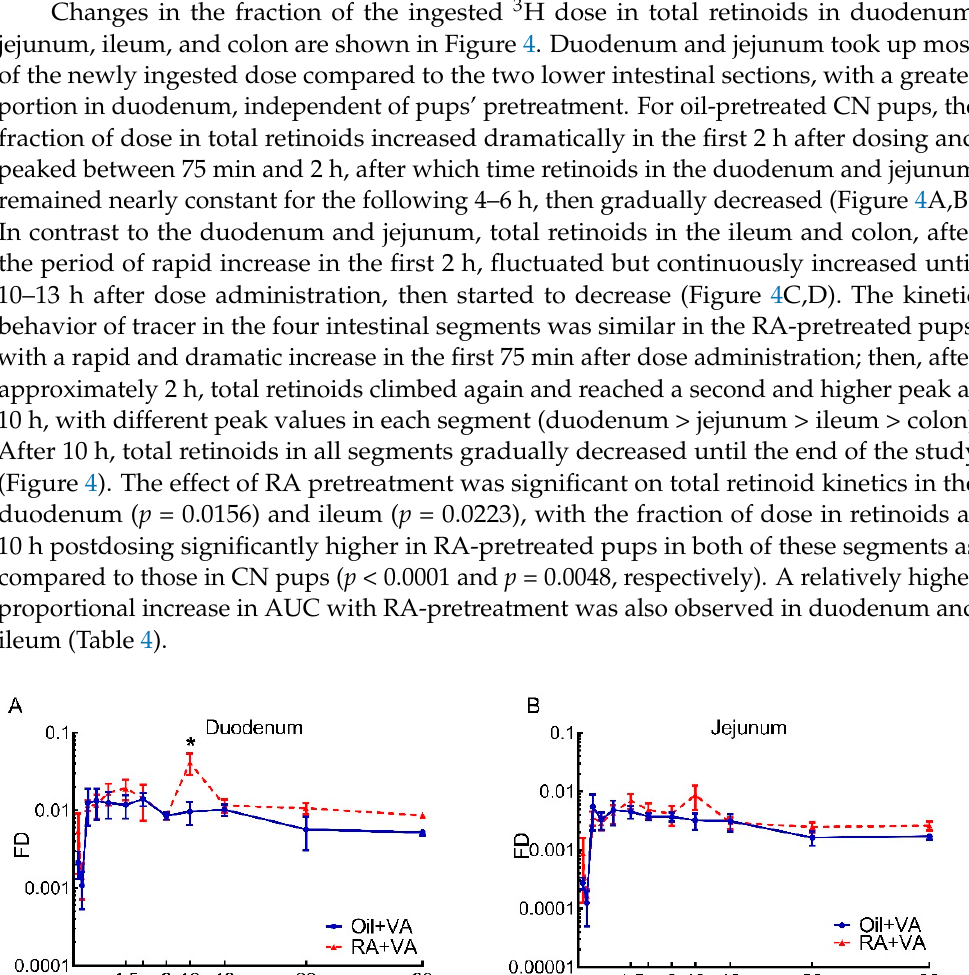
Table 3. VA mass accumulation in each intestinal segment after VA supplementation in oil-pre- treated and RA-pretreated neonates.